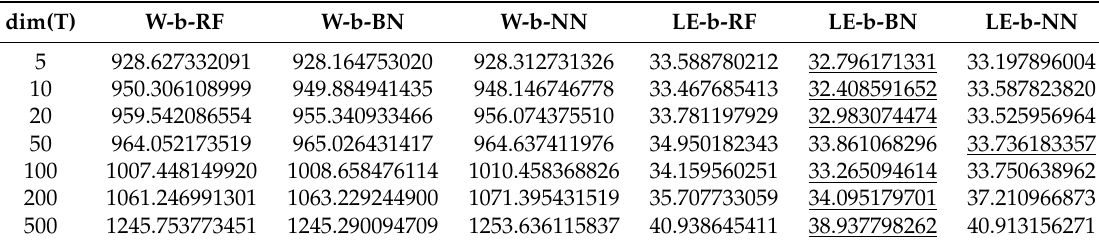
Table 11. Total computational time with different